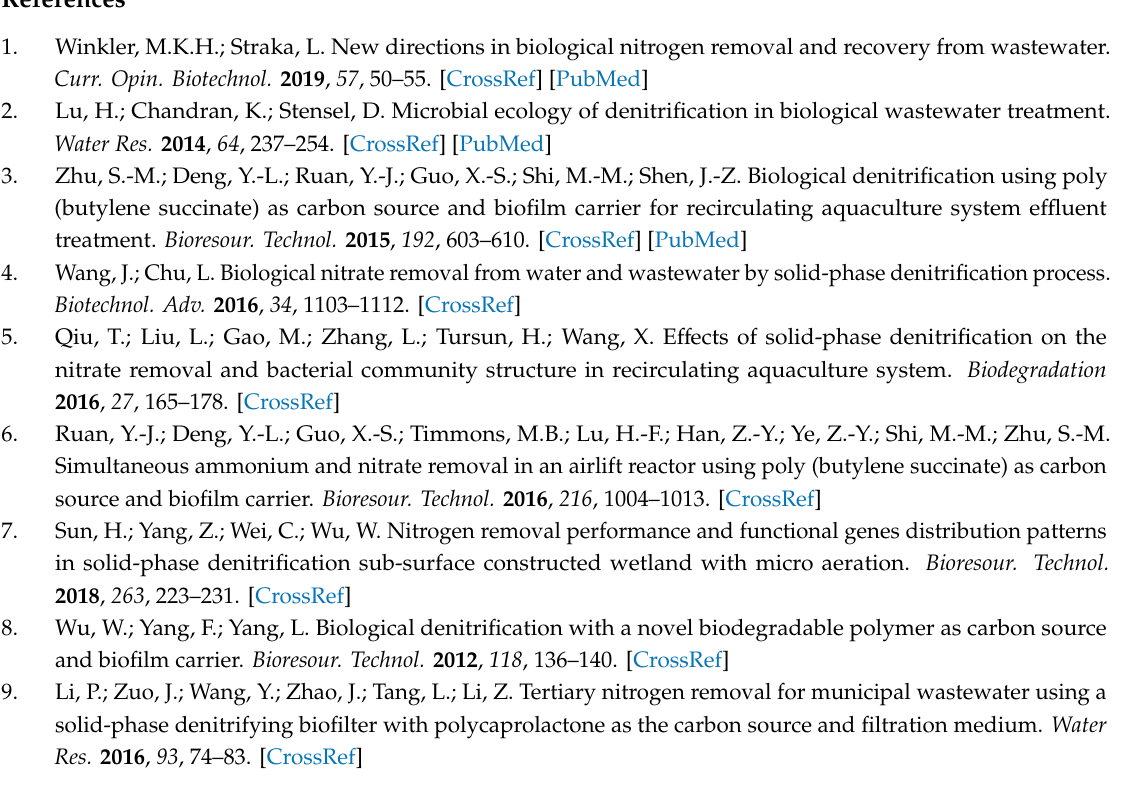
Figure S1: Scanning electron microscope micrograph of Pseudomonas balearica RAD-17; Figure S2: The specificity evaluation of PCR amplification assay. The specific DNA bands were detected by agarose gel electrophoresis, lane 1-7 represent the amplified products of 16S rDNA, gluD, gluS, napA, nirS, norB and nosZ, respectively; Figure S3: The agarose gel electrophoresis of the qRT-PCR amplification product of napA gene (A) and 16S rDNA genes (B) in one of the no-inoculum treatments. Lane 1-8 represent the time point of eight samples from 0 hour to 72